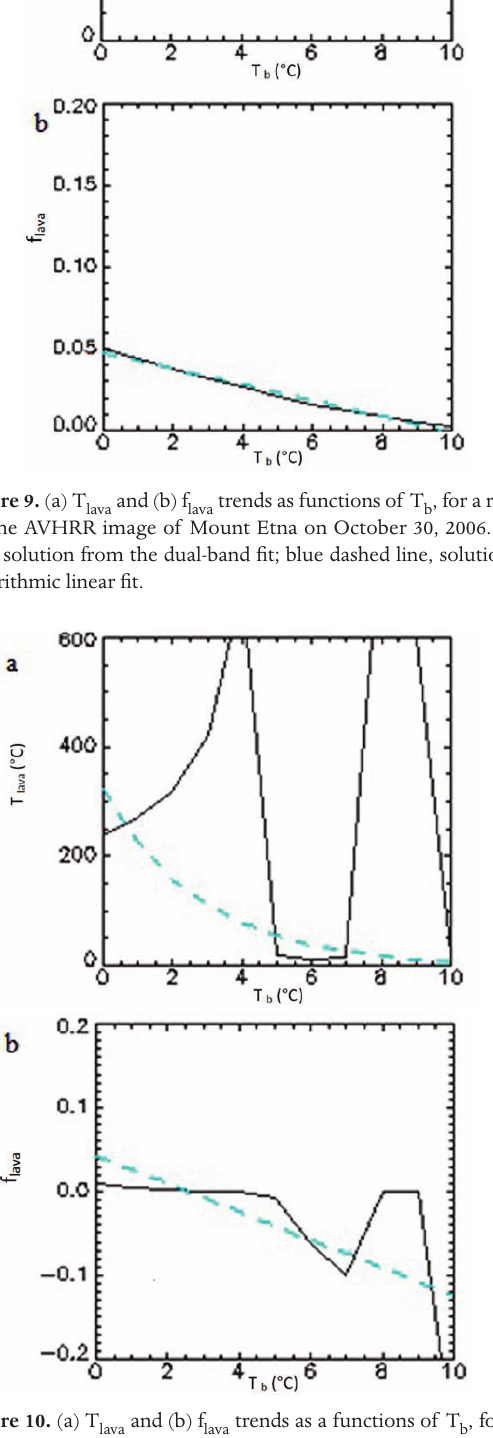
, for a rejected b